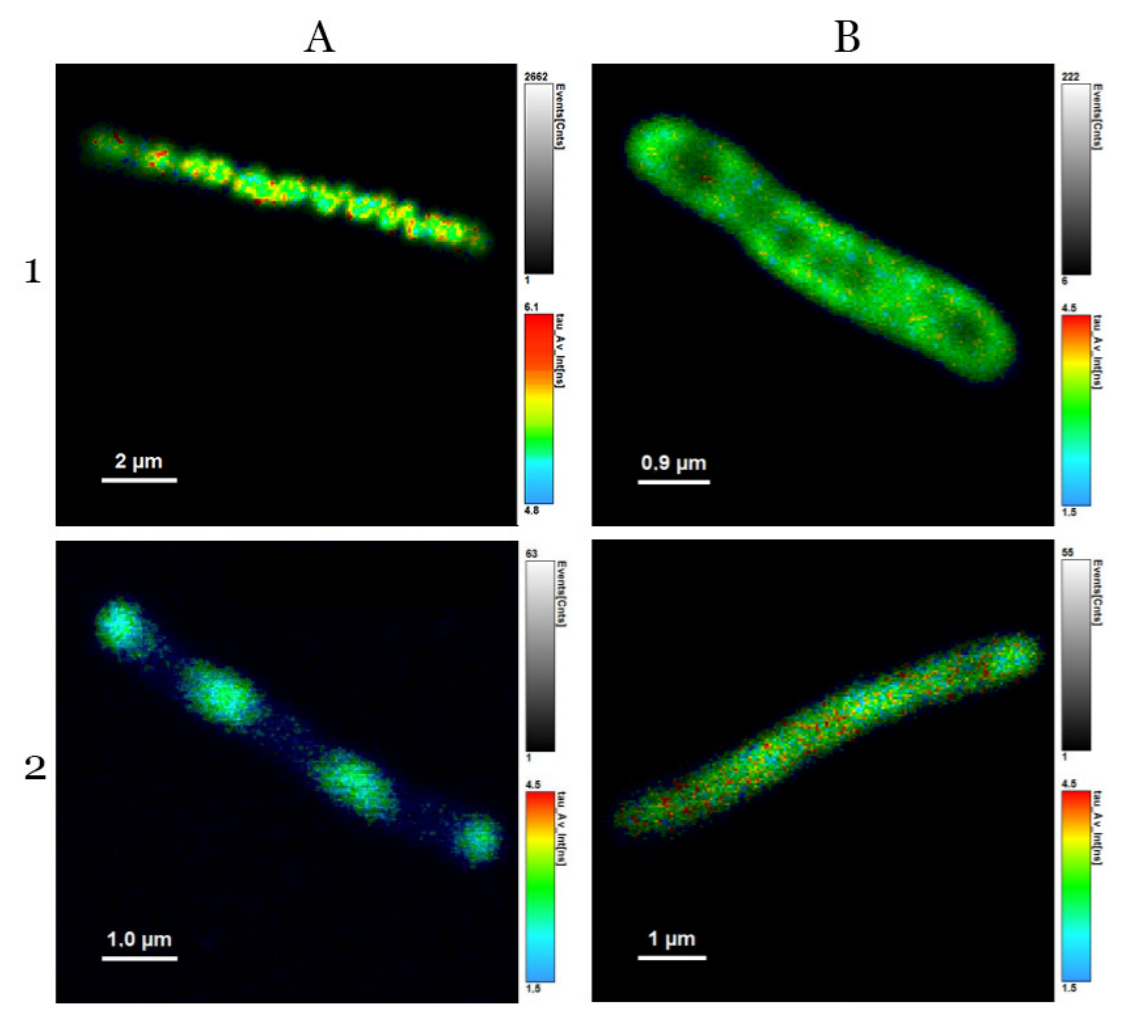
Figure 5. Cupriavidus necator H16 (1) and Cupriavidus necator PHB-4 (2), live cells ( A ) and dead cells ( B ); excitation with blue laser—467 nm.